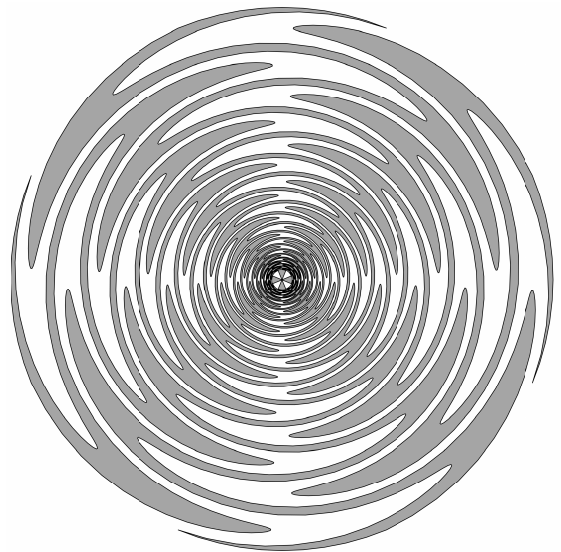
Figure 14. Traditional sinuous antenna having parameters: N = 4 arms, P = 20 cells, R 1 = 10 cm, τ = 0.8547, α = 65 ◦ , and δ = 22.5 ◦ . This antenna exhibits sharp discontinuities in the gain due to unintended resonate modes.